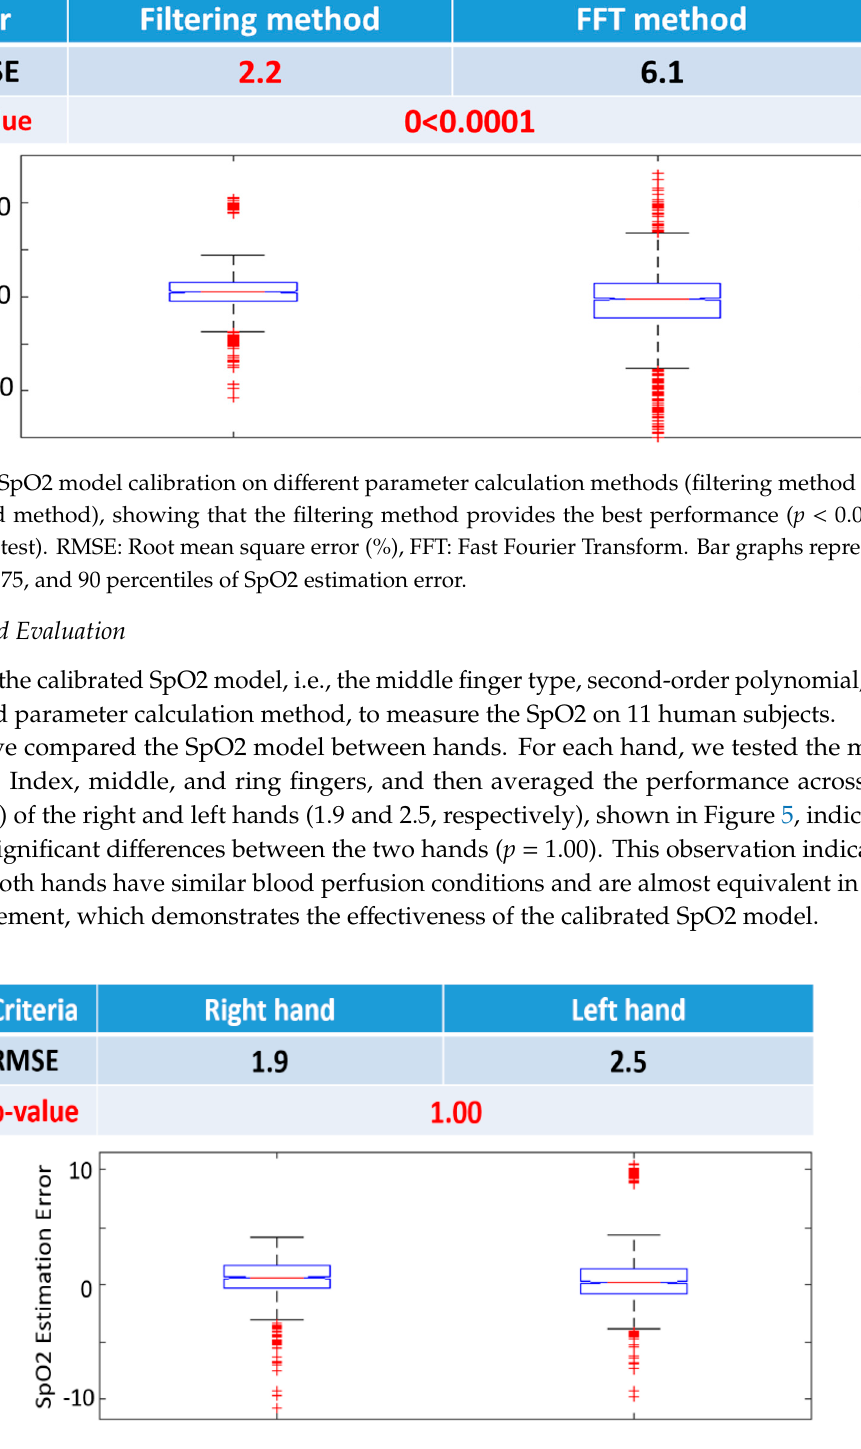
Figure 5. SpO2 model validation on different hands, showing that there is no significant difference between two hands. RMSE: Root mean square error (%), p -value is calculated using Wilcoxon signed-rank test. Bar graphs represent 10, 25, 50, 75, and 90 percentiles of SpO2 estimation error.